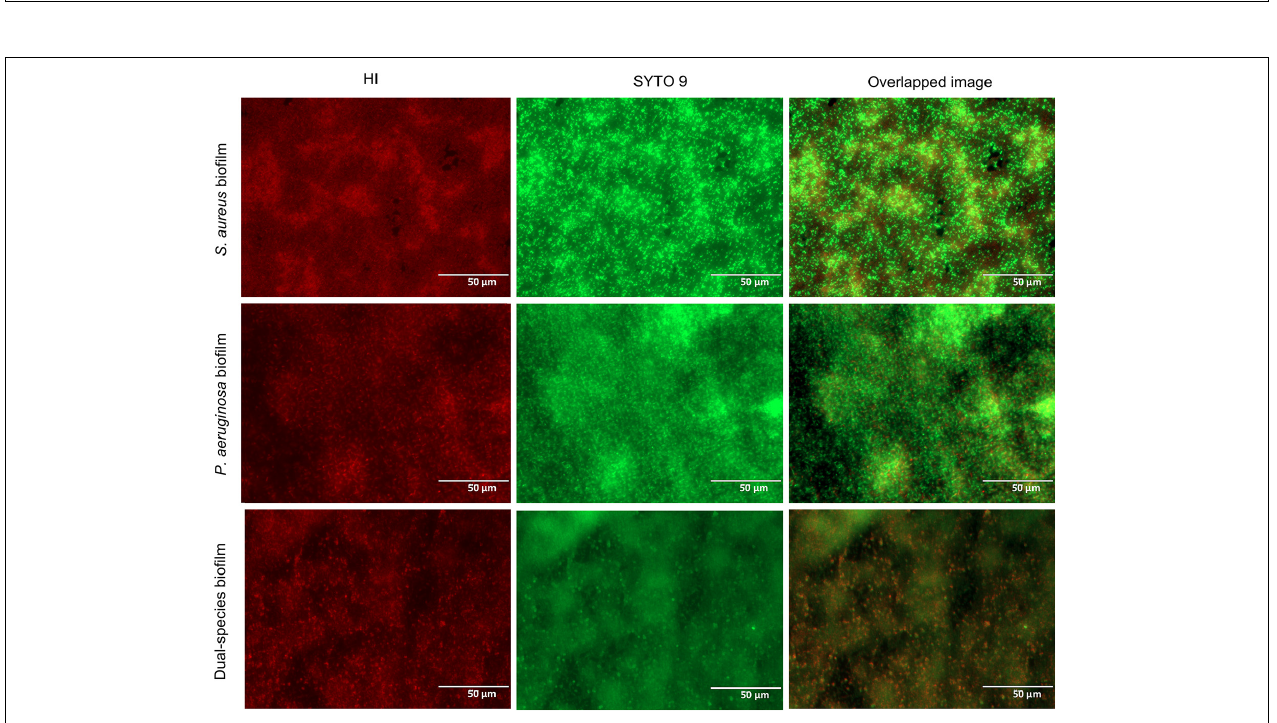
FIGURE 3 | Fluorescence microscopy images of single- and dual-species biofilms stained with a dye mixture of SYTO 9 (green) and hexidium iodide (red). Based on the growth condition of the co-culture model used, the images of the monoculture biofilms correspond to 42-h Staphylococcus aureus biofilm and 18-h Pseudomonas aeruginosa biofilm. Representative images were captured at a scale bar of 50 µ m.